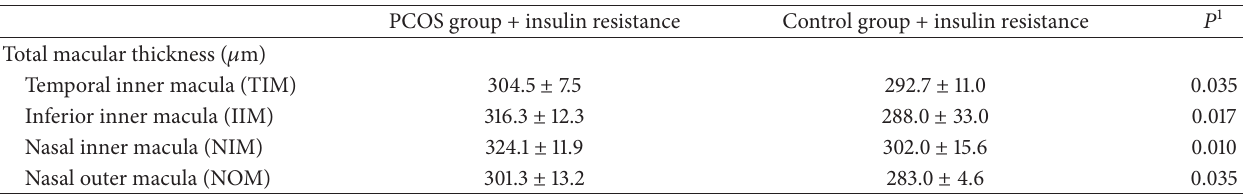
Table 4: Total macular thickness using HD-OCT: comparison between PCOS and control groups after metabolic